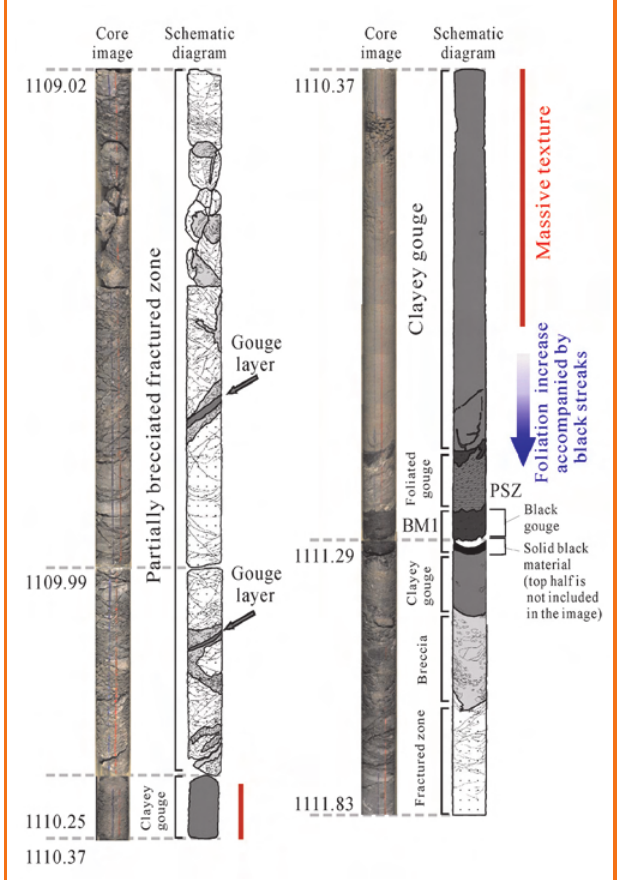
Figure 2. The core image and sketch diagram of fault zone FZA1111 from depth 1109.02 m to 1111.83 m of Hole A with descriptive comments. Note that the degree of deformation increases to the bottom of clayey gouge zone, and a 12-cm primary slip zone develops at depths of 1111.23–1111.35 m (from Ma et al.,